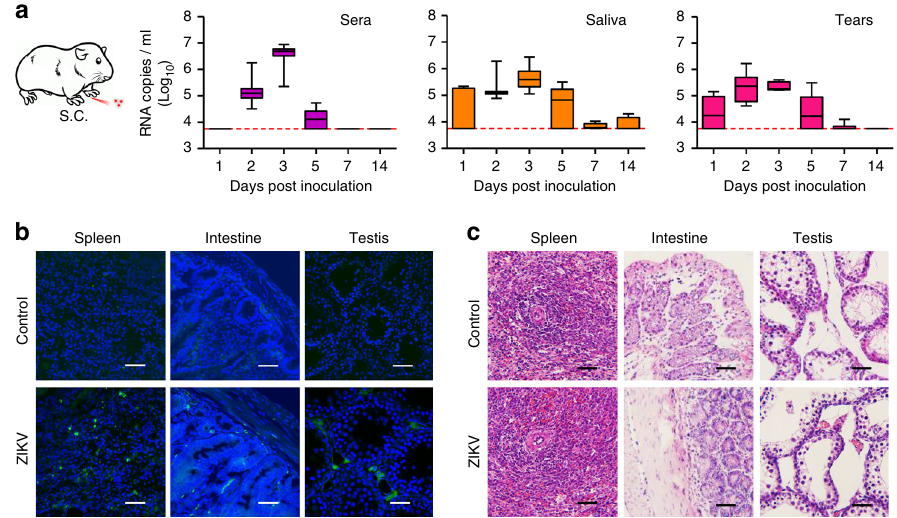
Fig. 1 Guinea pigs are susceptible to ZIKV infection. a Group of adult guinea pigs were s.c. inoculated with ZIKV and viral loads in the serum, saliva, and tear samples were determined using RT-qPCR at the indicated times. The number of infected animals evaluated on each day as follows: days 1 to 3, n = 8; days 5 to 7, n = 6; day 14, n = 4. Viral loads are expressed as RNA copies per milliliter. Dotted lines indicate the limit of detection. Whiskers: 5 – 95 percentile. b Immunostaining were performed with the convalescent serum from a ZIKV patient as the primary antibody. All tissue samples were collected from ZIKV-infected guinea pigs at 3 dpi. Nuclei were stained with DAPI. Scale bar: 50 μ m. c Histopathological changes in selected tissues from the ZIKV-infected guinea pigs at 3 dpi. Scale bar: 50 μ